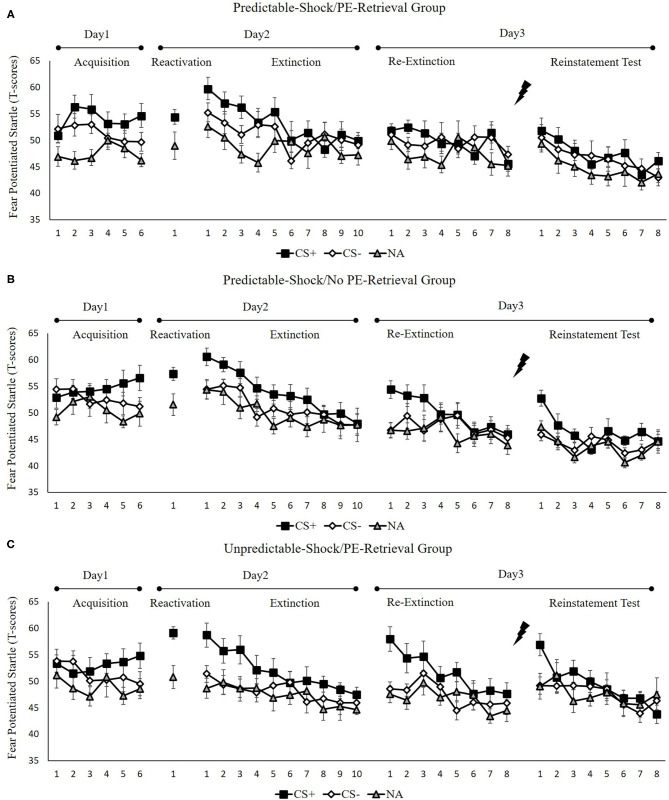
Mean startle potentiation to the fear-conditioned stimulus (CS+), the control stimulus (CS–), and the noise-alone (NA) trials during acquisition, memory reactivation, extinction, re-extinction, and reinstatement test for (A) the predictable-shock/PE-retrieval group (n = 18), (B) the predictable-shock/no PE-retrieval group (n = 19), and (C) the unpredictable-shock/PE-retrieval group (n = 16). Error bars represent SEM.